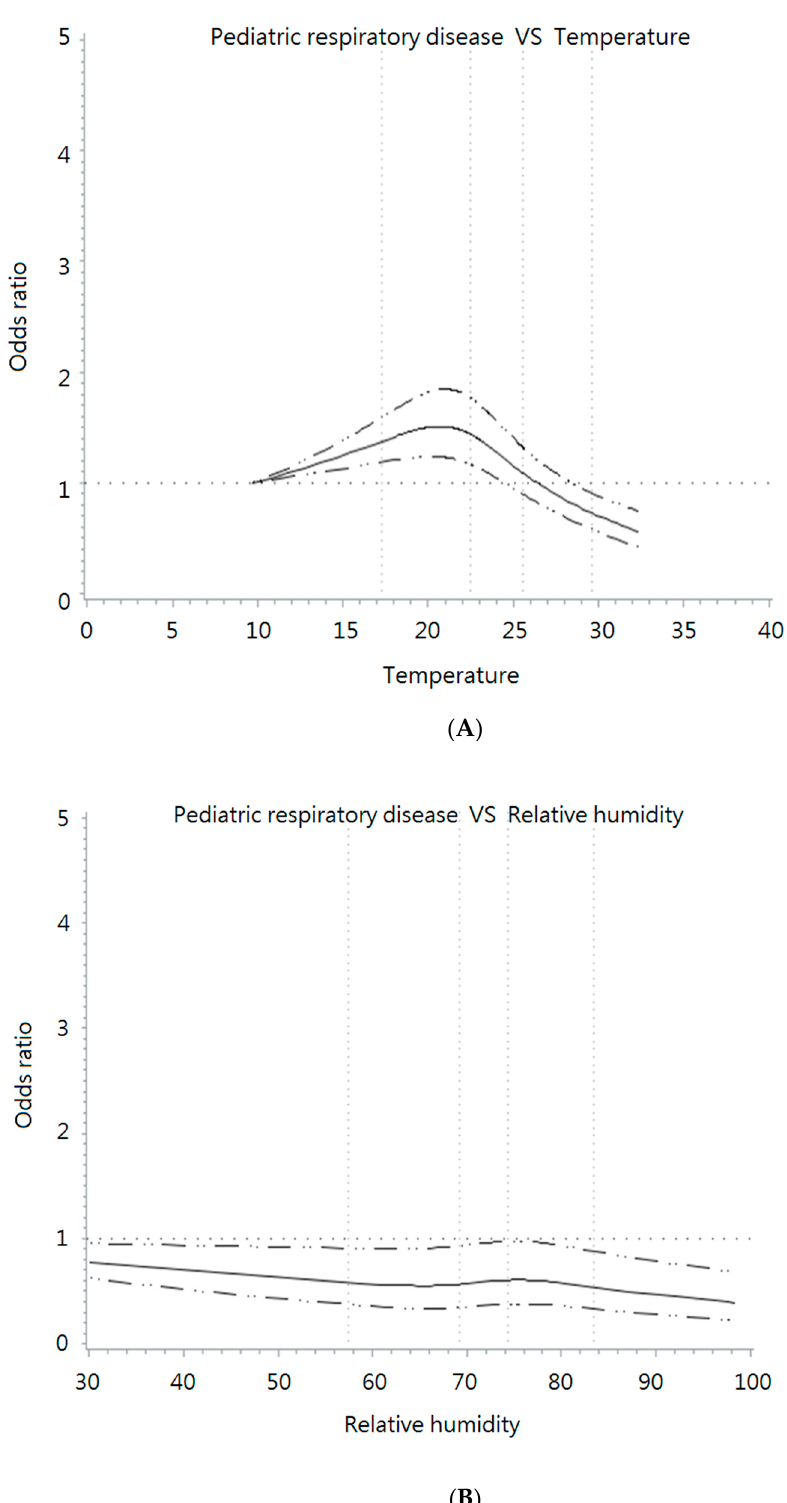
Figure 1. Restricted cubic spline for ( A ) temperature and ( B ) relative humidity. The reference exposure values for temperature and relative humidity were set at 10 ◦ C and 40%, respectively, including four